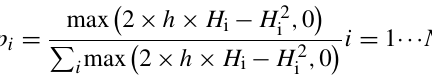
face seawater. The measurement frequency is hourly.